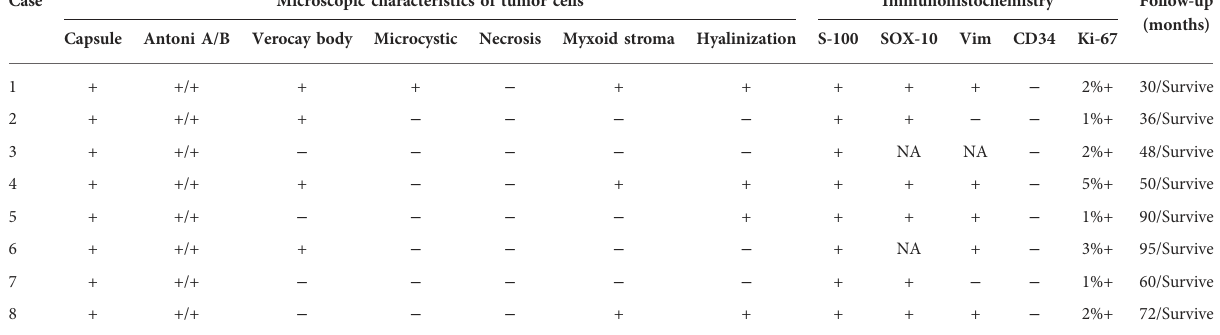
TABLE 3 Pathological features of eight patients with adrenal schwannoma.